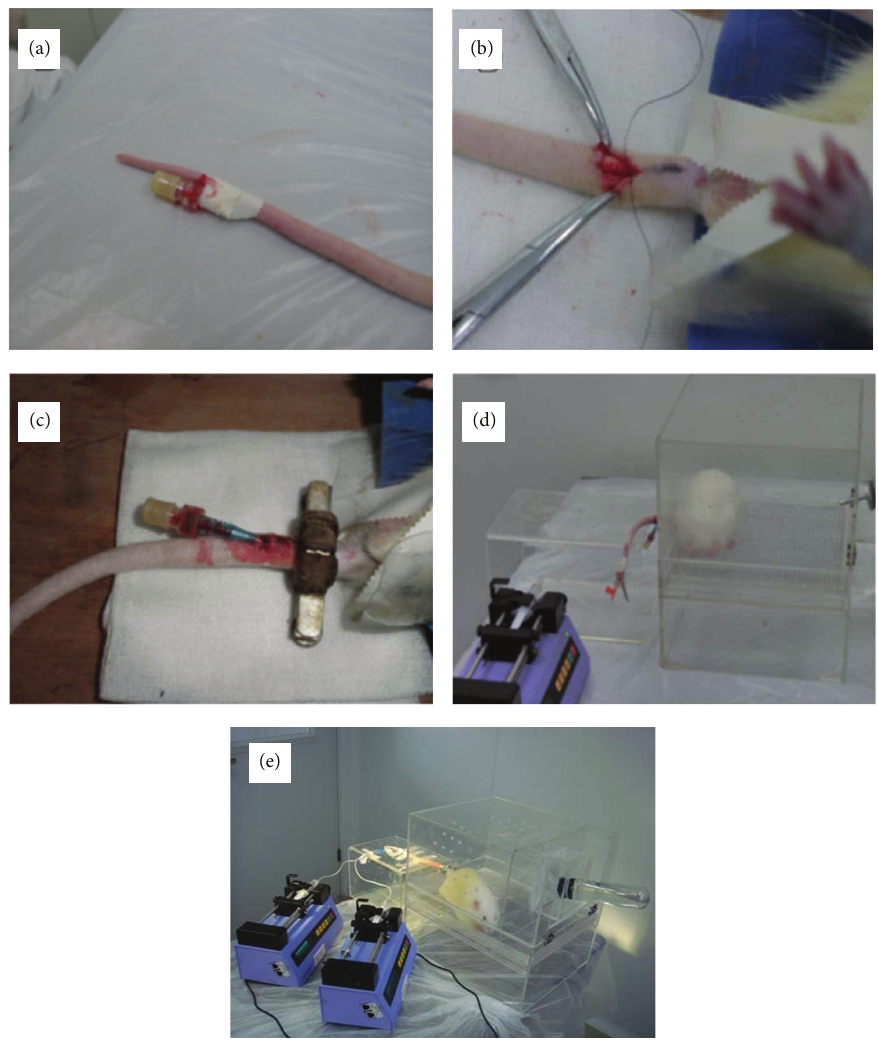
Figure 2: Establishment of platform of unstressed vein and artery implantation of catheters at the tails of the rats. (a) A catheter was implanted in the vein of the rat tail. (b and c) Another catheter was implanted into the artery of the rat tail with an adjustable copper clamp fixed at the tail root. (d) The rat was transferred into a self-made metabolic rage to rest before tracing study. (e) The unstressed tracing model with vein continuously injected tracers and artery catheters for drawl of blood samples (published by Zhai et al. [16]).